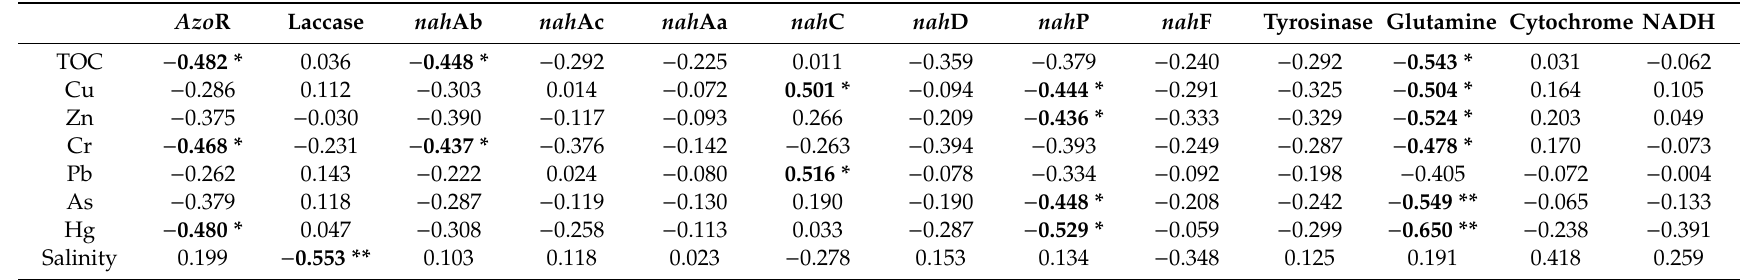
Table 2. Pearson’s correlation coe ffi cient (r) of azo dye degrading related genes and environmental parameters in sediment samples. (* p < 0.05; ** p < 0.01).